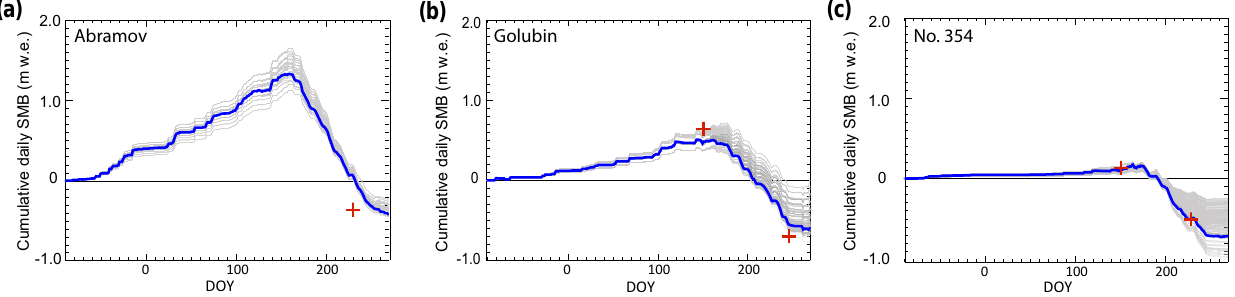
Figure 13. Cumulative daily glacier-wide SMBs inferred from the snow line approach for (a) Abramov, (b) Golubin and (c) Glacier no. 354 for the year 2014 (blue line). The grey lines indicate the spread obtained by using different constant parameters to run the model (Sect. 4) and the red cross indicates the measured glaciological SMB for both the winter and the annual